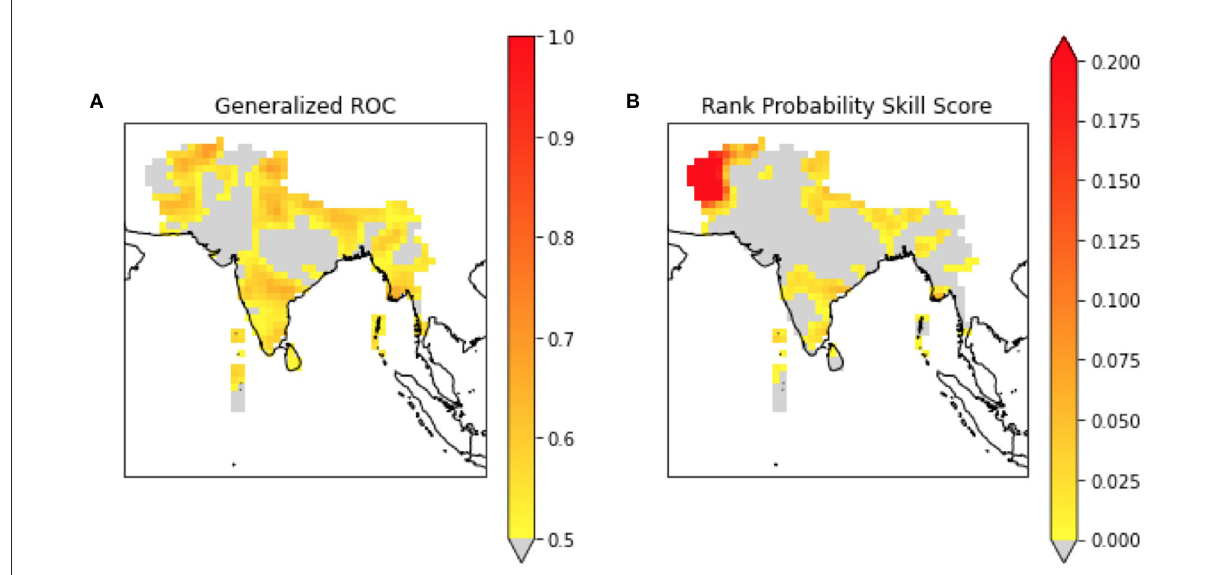
FIGURE8 Generalized ROC (A) and Rank Probability Skill Score (B) for POELM-based probabilistic forecasts of South Asian Summer Monsoon Rainfall.